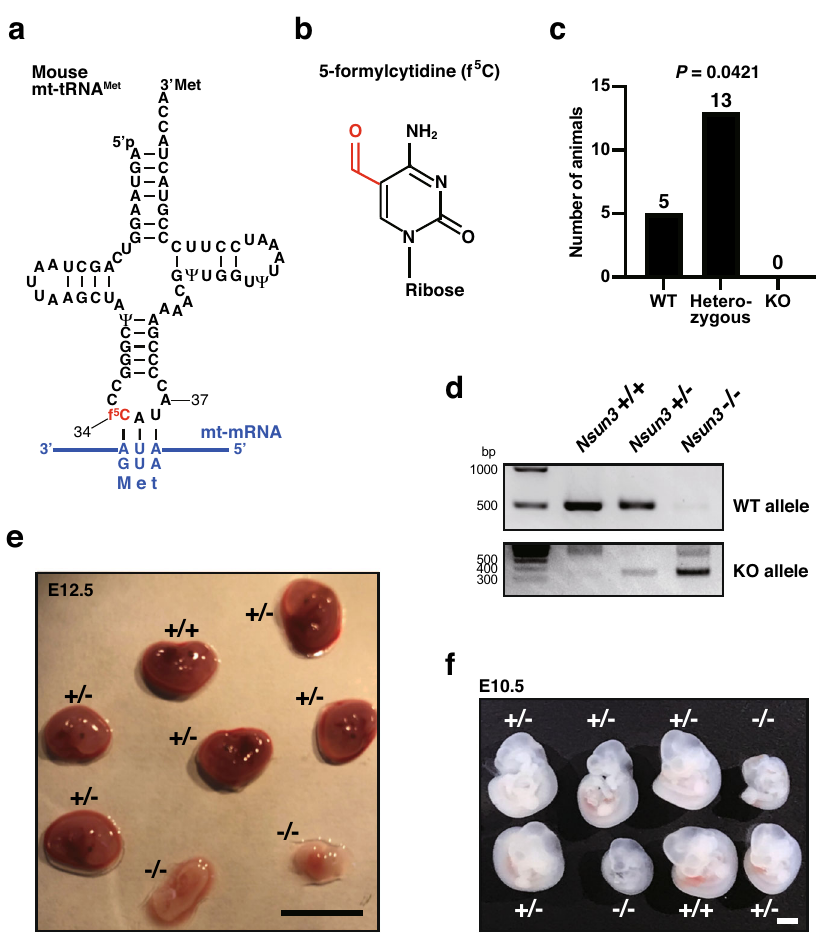
Fig. 1 Embryonic lethality of whole-body Nsun3 KO mice. a Secondary structure of the mouse mitochondrial (mt-) tRNA Met with modi fi ed nucleosides: pseudouridine ( Ψ ) and 5-formylcytidine (f 5 C). The modi fi cations are depicted based on human and bovine mt-tRNA Met modi fi cations 7,50 . The nucleoside position is numbered following conventional guidelines 51 . Note that f 5 CAU anticodon can base pair with two mitochondrial methionine-encoding mRNA codons AUG and AUA. b Chemical structure of f 5 C. The formyl modi fi cation at the cytidine C5 position is shown in red. c Numbers of animals obtained by crossing parental heterozygous ( Nsun3 + / − ) mice. P value was calculated by the chi-square test. d Genotyping analysis of embryos at stage E12.5. e , f Morphology of WT ( + / + ), heterozygous ( + / − ), and KO ( − / − ) embryos at stages E12.5 ( e ) and E10.5 ( f ) removed from the uterus of a heterozygous mother mouse. Scale bars, 5 mm ( e ) and 1 mm ( f showed left ventricle posterior wall thickening during his 60s and 70s 26,30 .